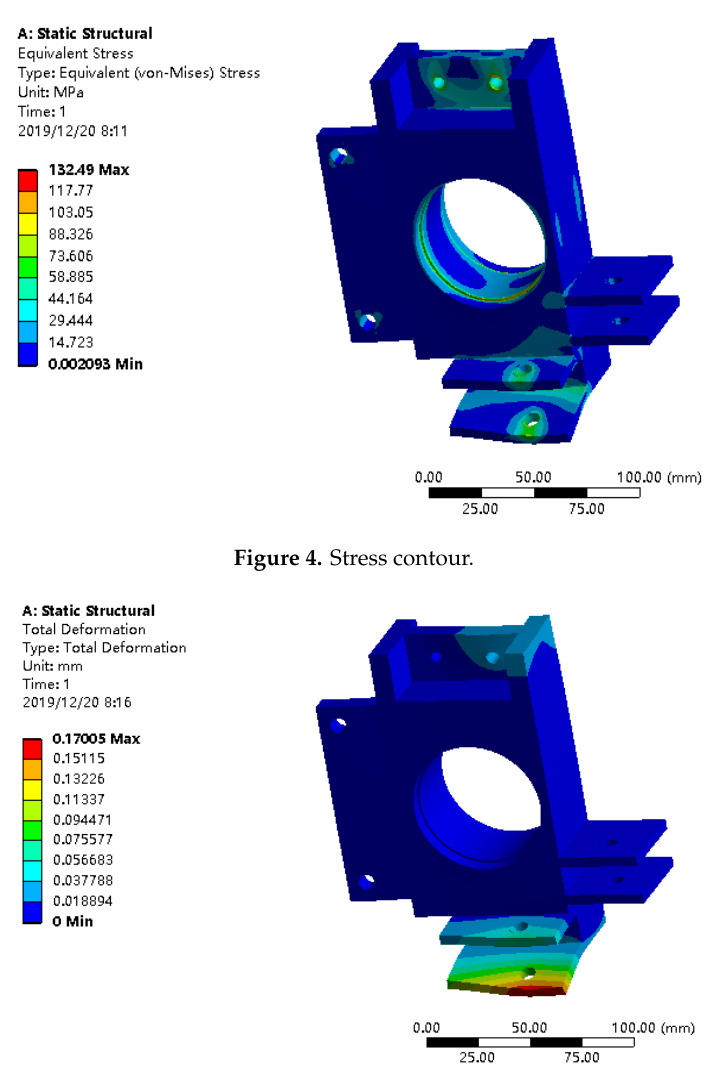
Figure 3. The initial finite element model (FEM).